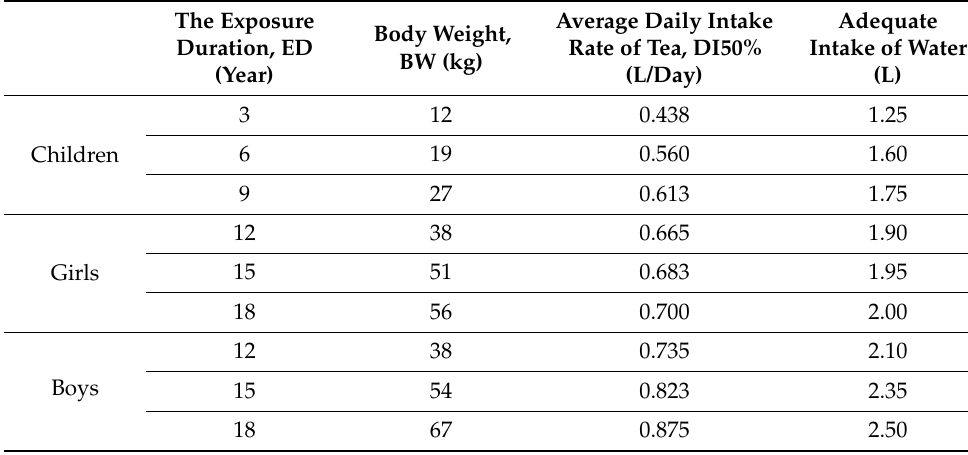
Table 1. Data used to calculate chronic daily intake of fluoride from tea infusion